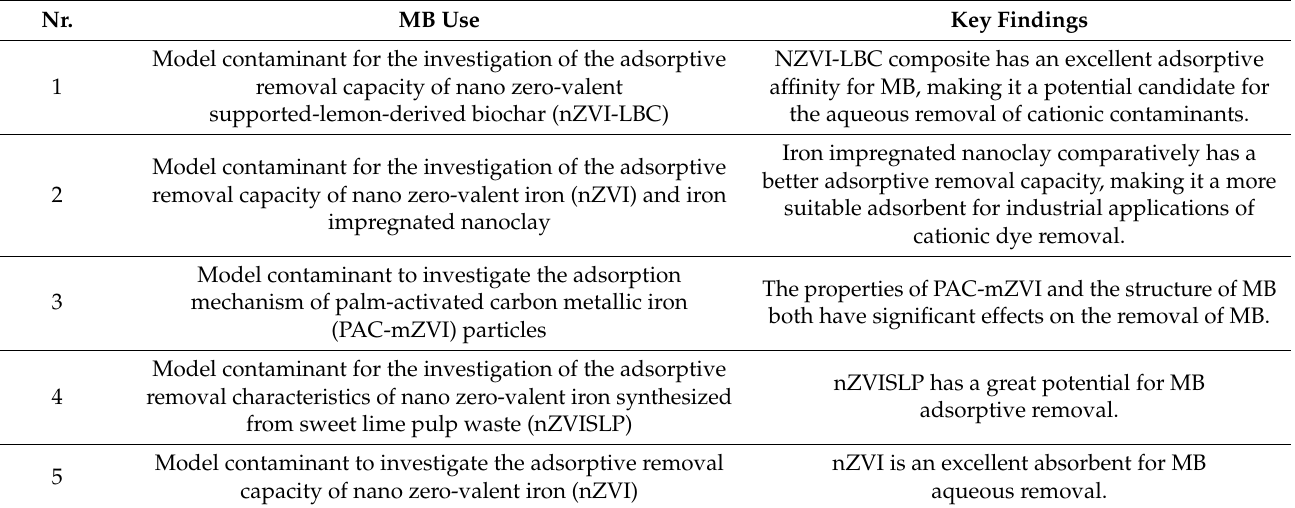
Table 3. Summary of the use of MB and the key findings for each of the five selected articles used to illustrate the evidence that the lack of true collaboration has been the major obstacle to Fe 0 remediation research